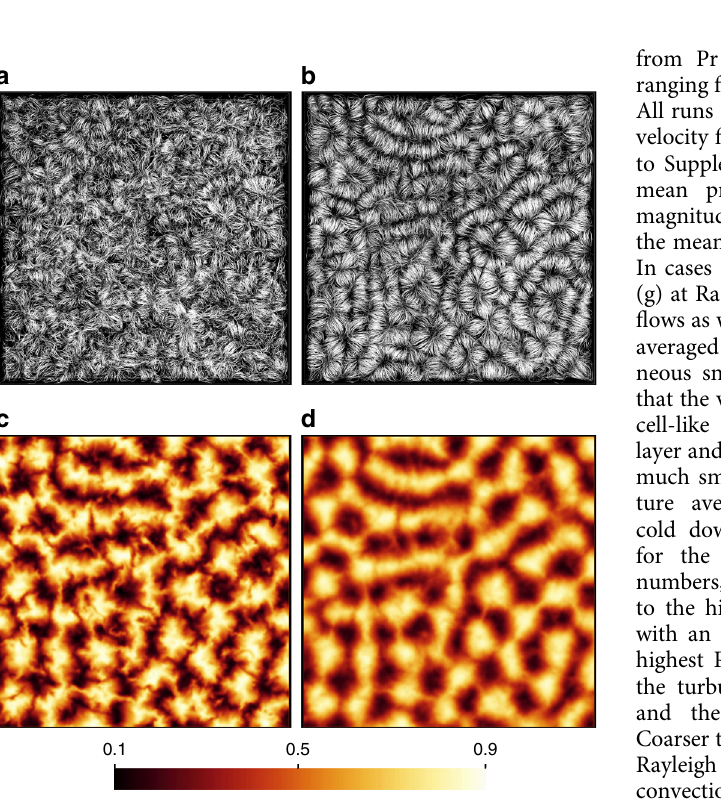
Fig. 1 Instantaneous and time-averaged fi elds. Field line plots of the instantaneous ( a ) and time-averaged ( b ) velocity for Pr = 0.021 and Ra = 10 5 . View is from the bottom. Corresponding instantaneous ( c ) and time- averaged ( d ) temperature fi eld in midplane. Averaging time is 27 free-fall times ( T f ). The three-dimensional simulation domain is resolved by more than 1.2 billion mesh